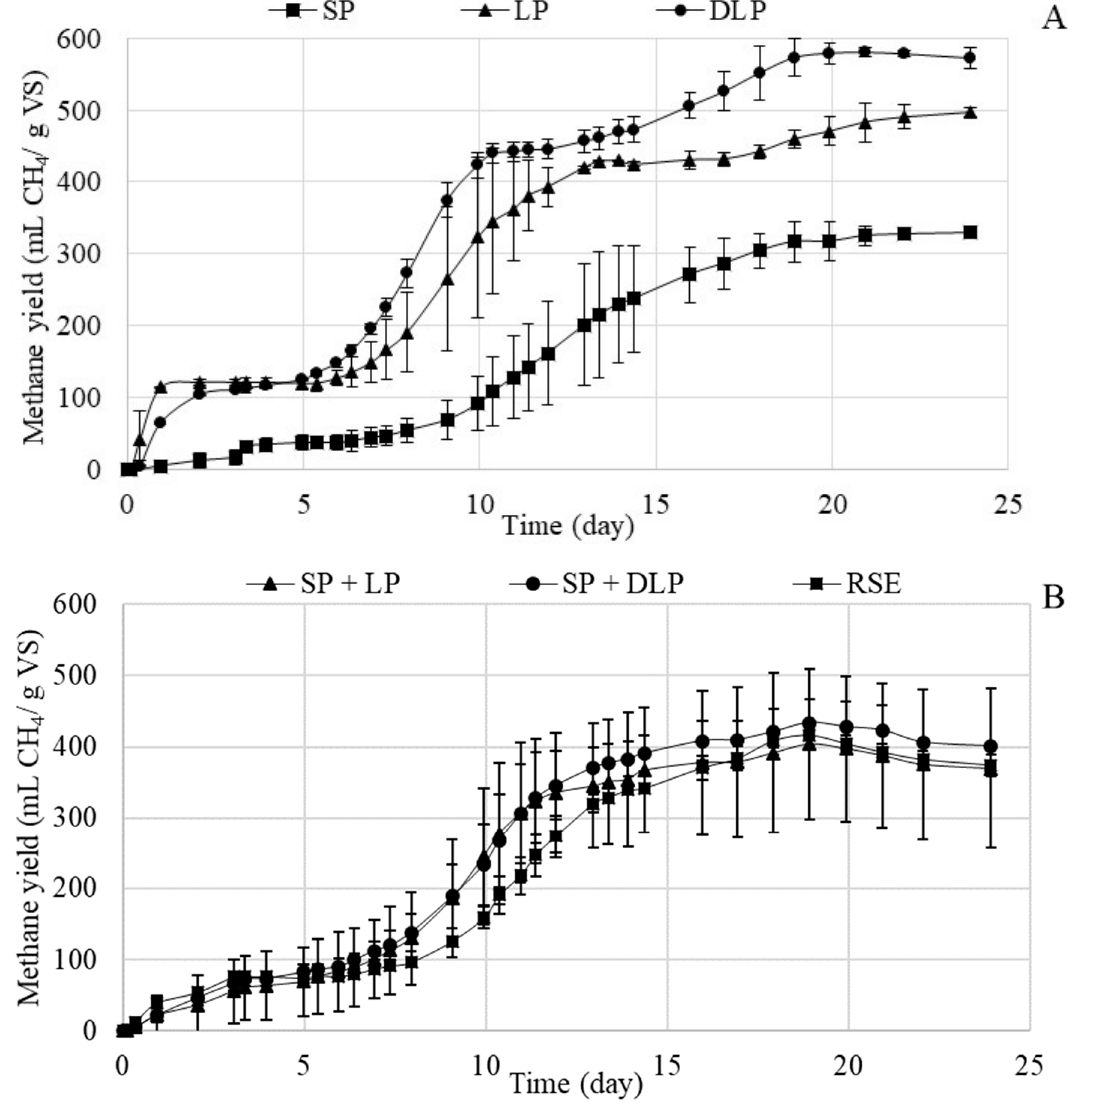
Figure 2. ( A) : Variation of cumulative methane production (mL CH 4 /g VS) (VS, total volatile solids) with time for LP (liquid phase), SP (solid phase), and DLP (dephenolized liquid phase) after 170 °C hydrothermal treatment with their standard deviations; ( B) : Variation of cumulative methane production (mL CH 4 /g VS) with time for the untreated RSE (residual strawberry extrudate), SP + LP and SP + DLP mixtures after 170 °C hydrothermal treatment with their standard deviations.